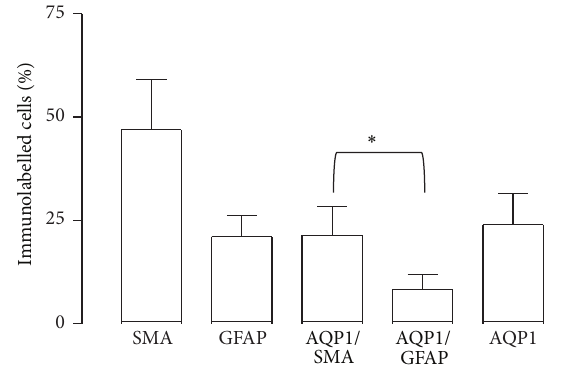
Figure 4: Quantification of cells expressing AQP1, 𝛼 SMA, AQP1/ 𝛼 SMA,GFAP,andAQP1/GFAPinPVRandERMmembranes (data are expressed as % of total cell number (DAPI-labelled cells), mean ± S.E.M.). Paired Student’s 𝑡 -test assessed the significant difference between the number of cells labelled with AQP1/ 𝛼 SMA and AQP1/GFAP ( ∗ 𝑃 < 0.05